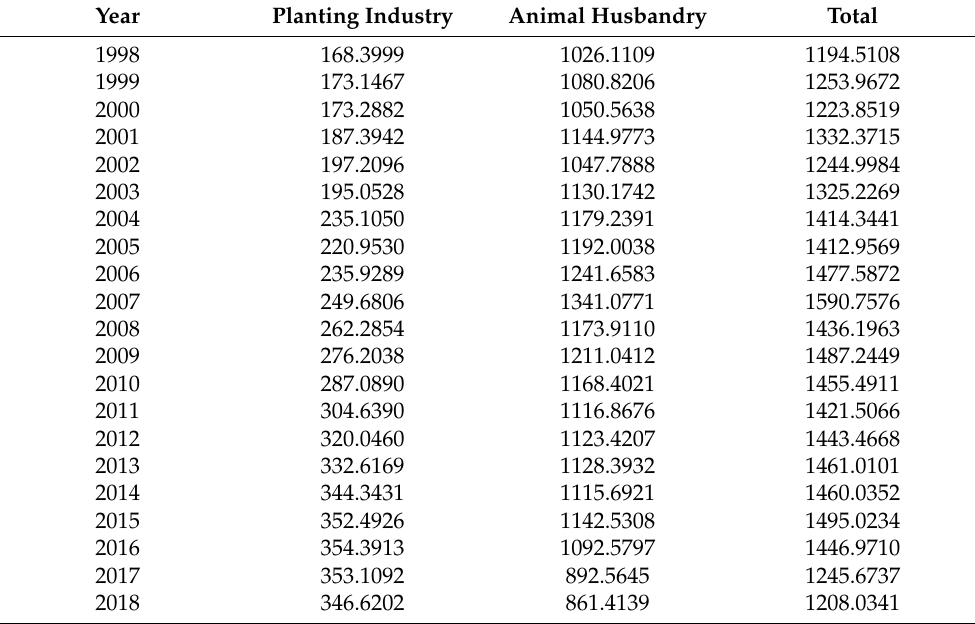
Table 5. Amount of agricultural carbon emissions in Jilin Province from 1998 to 2018 (unit: 10,000